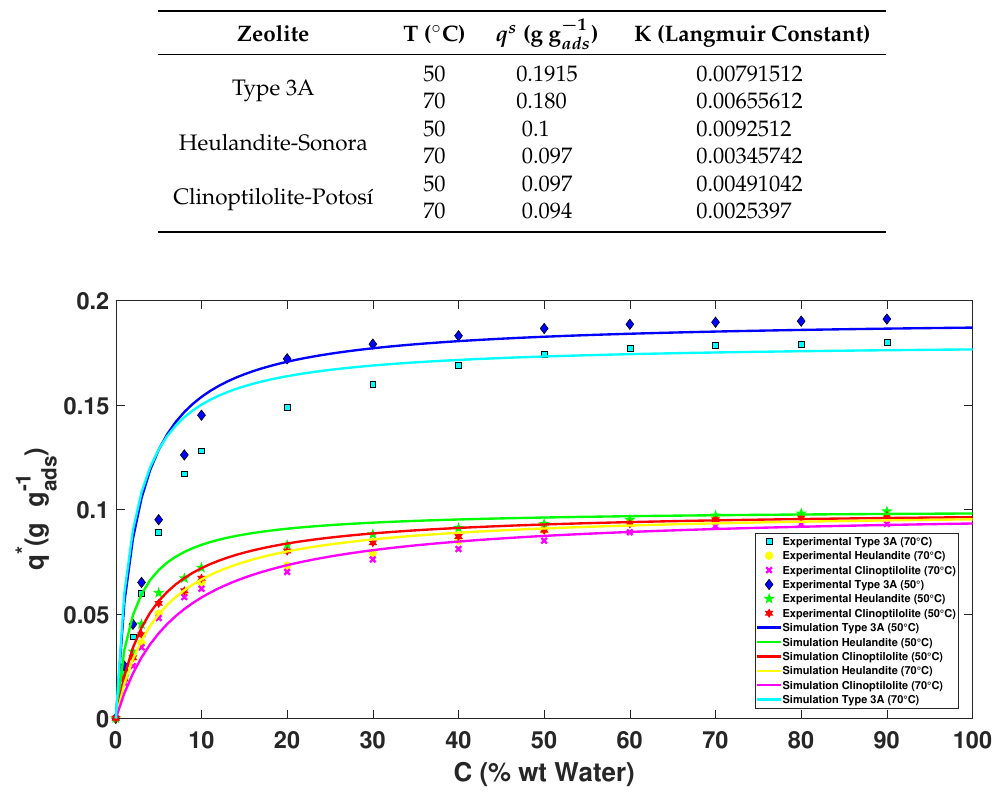
Figure 6. Langmuir adsorption isotherms for the H 2 O / C 2 H 5 OH